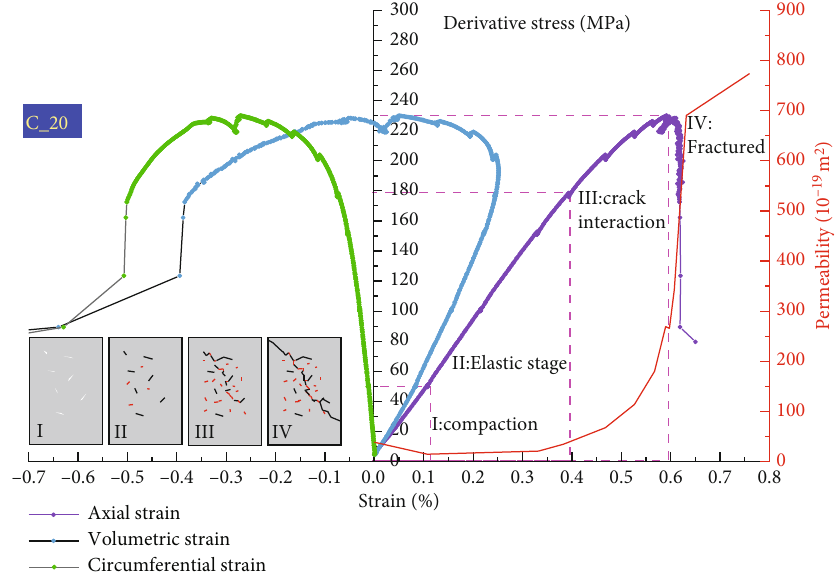
Figure 2: Experiment data of stress-strain and permeability in the specimen of C20.